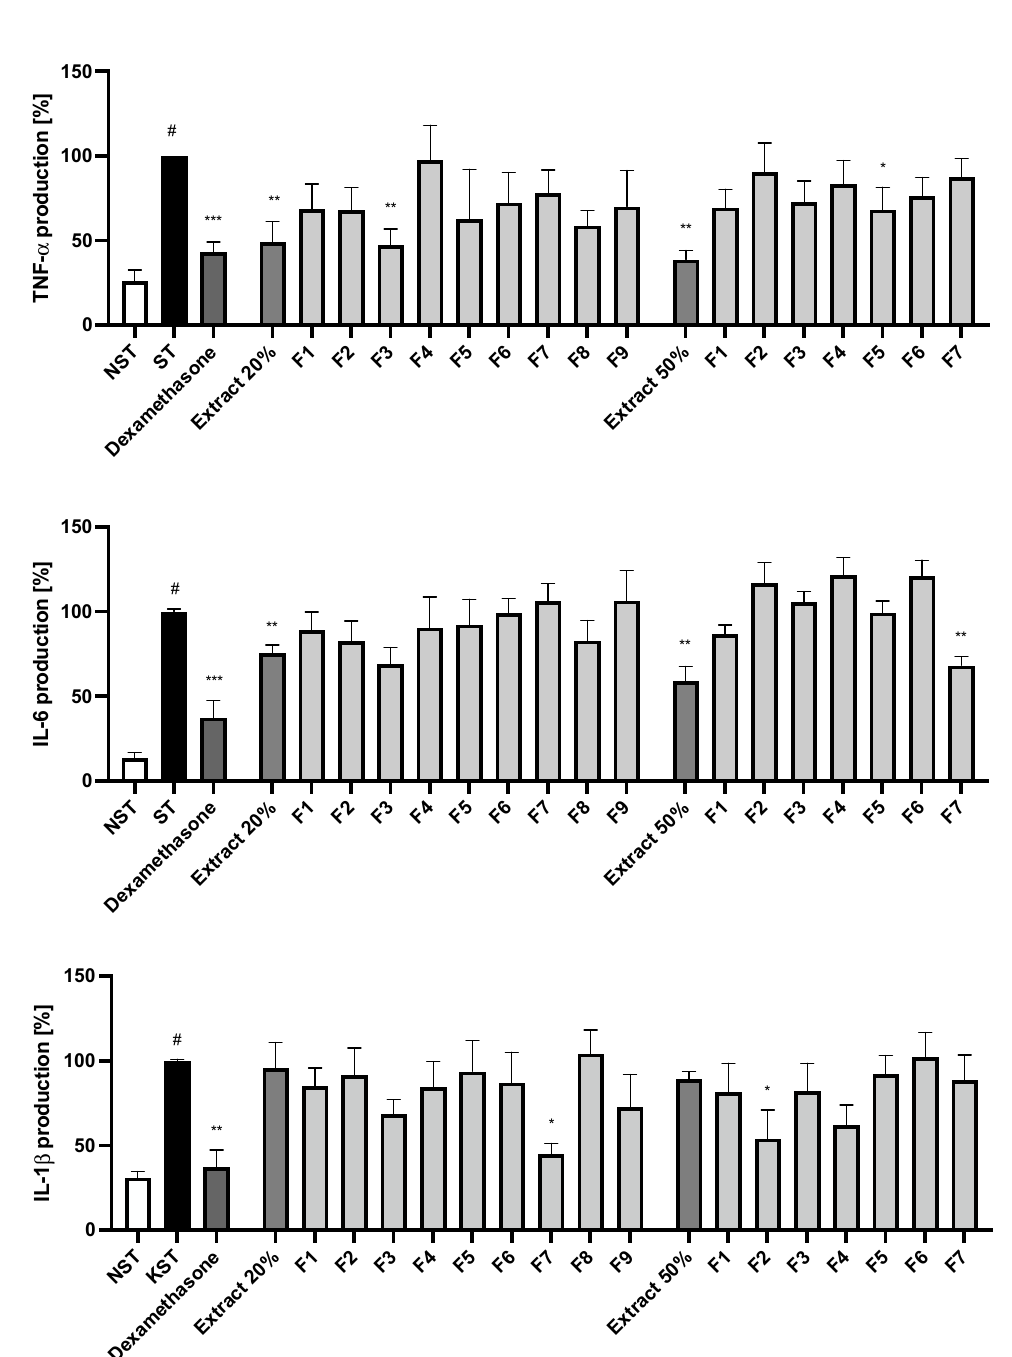
Figure 3. The influence of methanolic extracts and selected fractions on ( A ) TNF- α , ( B ) IL-6 and ( C ) IL-1 β production by LPS-stimulated monocytes/macrophages. Non-stimulated cells (NST), LPS- stimulated (ST) monocytes/macrophages and LPS-stimulated monocytes/macrophages treated with 50 μ g/mL of infusion, extracts and fractions. Dexamethasone (20 μ M) was used as a positive control. Data are expressed as mean ± SEM (three separate experiments performed on monocytes/macrophages isolated from independent donors). Statistical significance: * p < 0.05, ** p < 0.01, *** p < 0.001 versus stimulated control, # statistically significant ( p < 0.001) versus non-stimulated